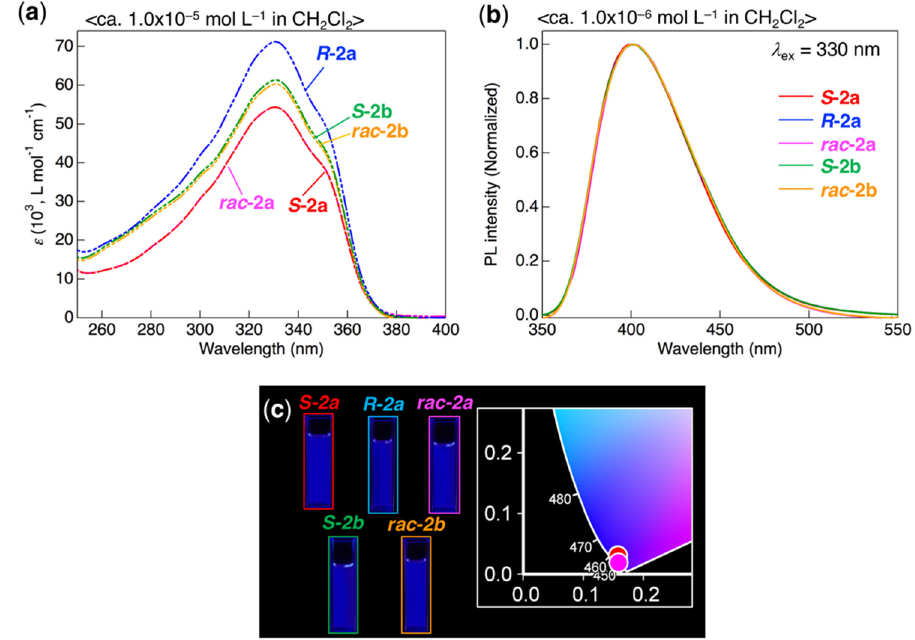
Figure 6. ( a ) Absorption and ( b ) PL spectra for 2a and 2b in dilute CH 2 Cl 2 solution. ( c ) Photographs of PL under UV irradiation ( λ ex = 365 nm) and the Commission Internationale de l’Eclailage (CIE) chromaticity diagram for the PL. Table 2. Photophysical (absorption and PL) data of 2a and 2b in dilute CH 2 Cl 2 solution.